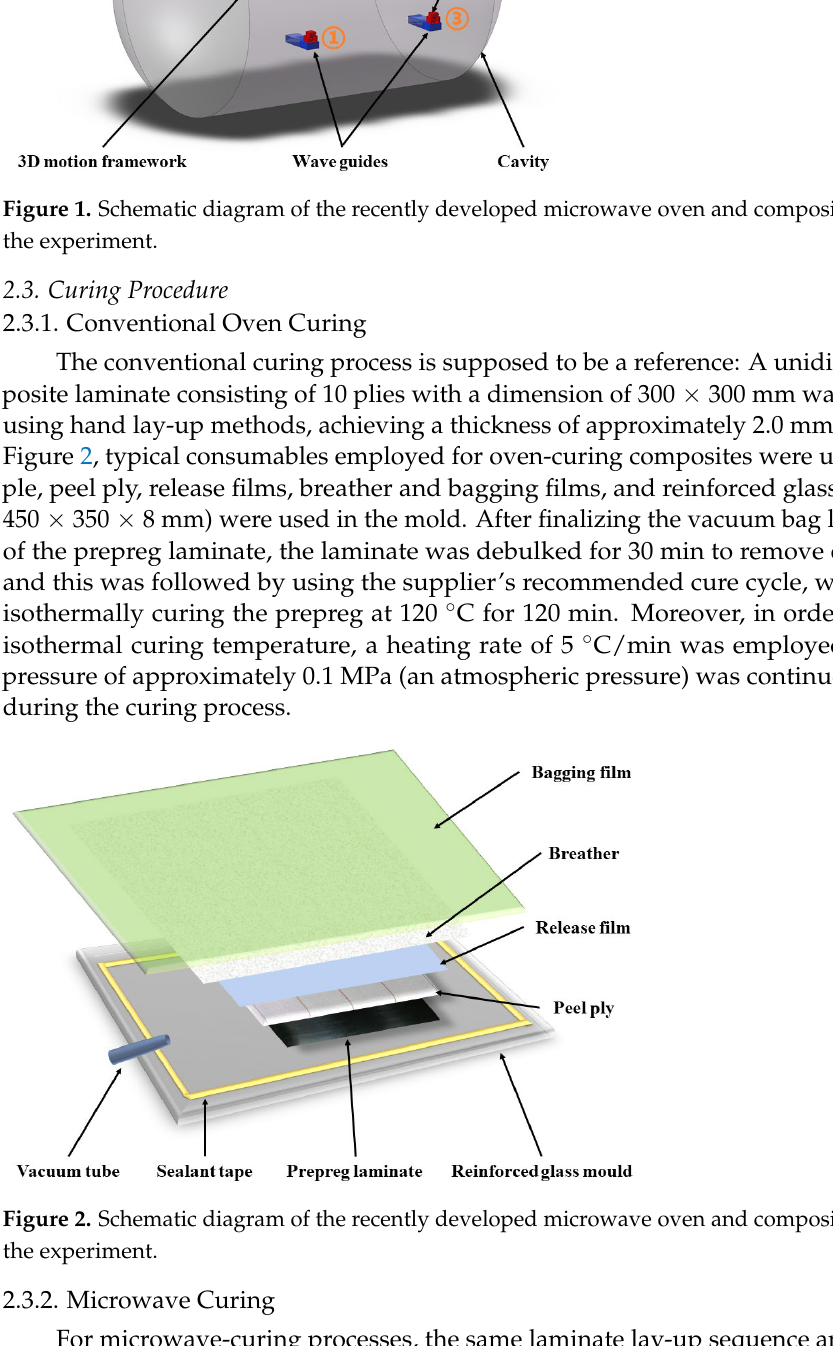
Figure 1. Schematic diagram of the recently developed microwave oven and composite plate used in the experiment.